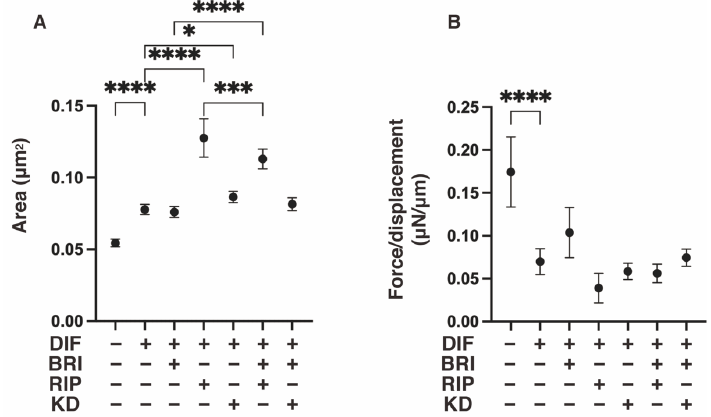
Figure 5. Effects of ROCK-i and/or BRI on the physical properties, size and stiffness of the 3T3-L1 3D spheroids. The 3T3-L1 cells were 3D-cultured under several conditions: preadipocytes of 3T3-L1 cells (DIF−) and their adipogenic differentiation (DIF+) with or without 10 µM ripasudil (Rip) or KD025, and/or BRI. The mean area sizes (µm2) were measured, and the results are plotted in panel ( A ). Alternatively, the stiffness was also measured using a microsqueezer, and the force required to induce deformation until half-diameter by 20 s (µN/µm force/displacement) was measured and is plotted in panel ( B ). All experiments were performed in triplicate using fresh preparations, each consisting of 16 spheroids. Data are presented as the arithmetic mean ± standard error of the mean (SEM). * p < 0.05, *** p < 0.005, **** p < 0.001, and other pairs were not statistically significant (ANOVA followed by a Tukey’s multiple comparison test).